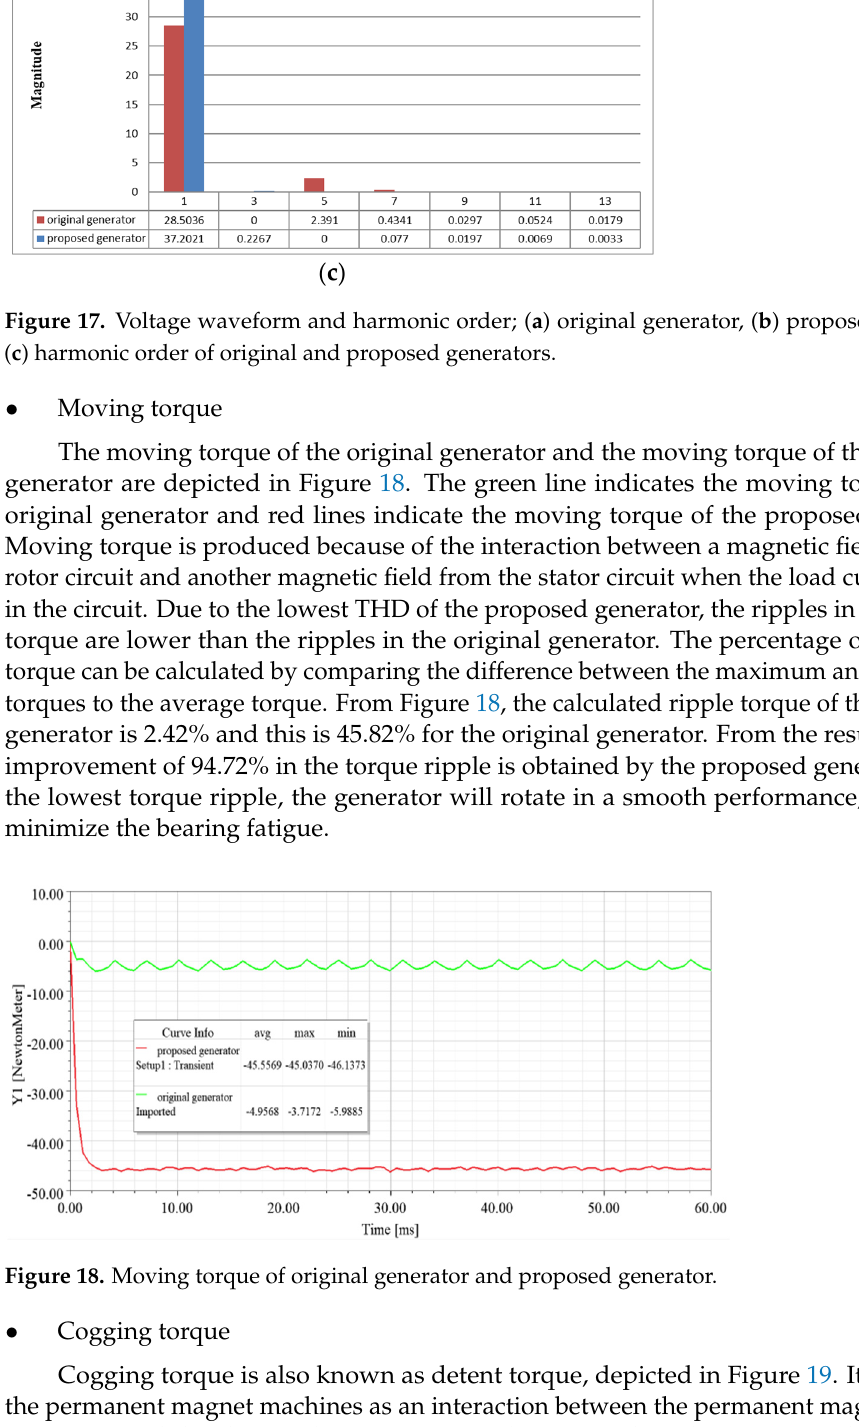
Figure 18. Moving torque of original generator and proposed generator.